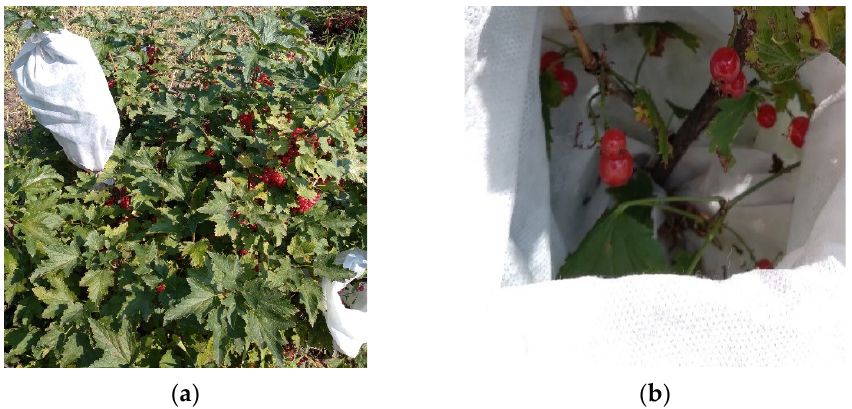
Figure 11. ( a ) Isolation bags on the maternal form of red currants and ( b ) berries obtained as a result of intercultivar hybridization of ‘Jonkheer van Tets’ cultivar. The site of the primary variety study of red currants at the Russian Research Institute of Fruit Crop Breeding.